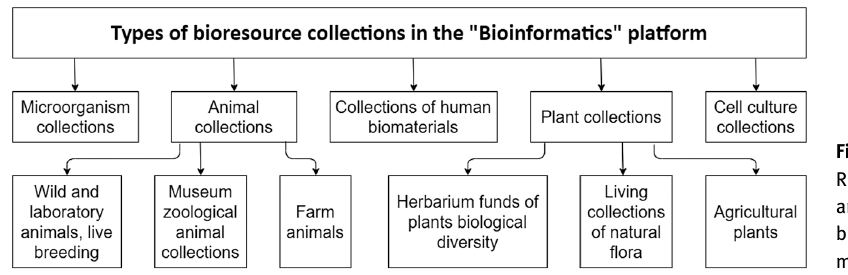
Figure 2: Organizations of the and Higher Education support bioresourcecollectionsofnine main